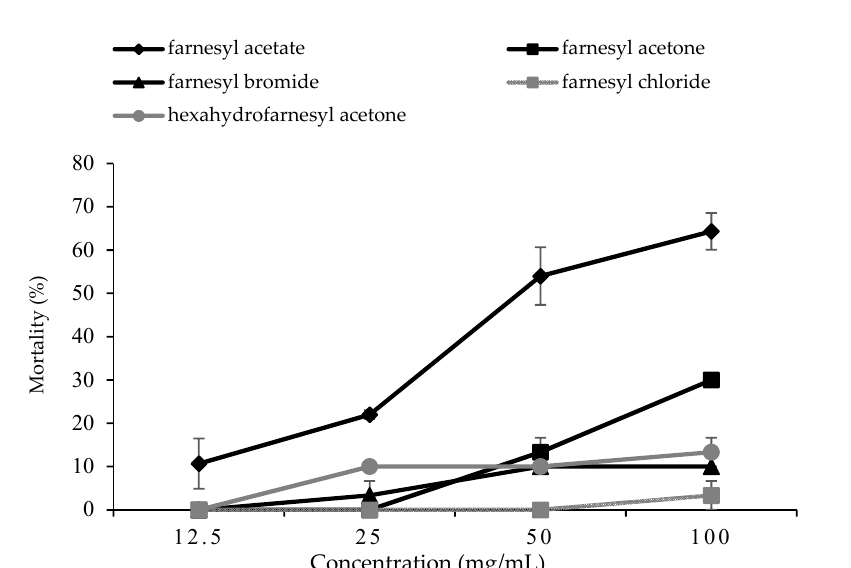
Figure 1. Percentage mortality of P. xylostella treated with farnesyl derivatives at various concentra- tions at 96 h. Data are shown as the mean ± standard error (SE). Table 2. Toxicity of farnesyl derivatives on the second instar larvae of P. xylostella. LC 50 , sublethal concentration.